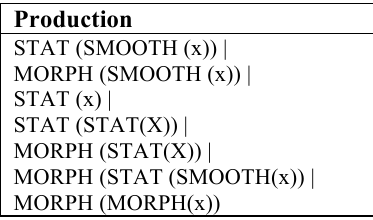
Table 3: Grammar used to generate features. Additionally, new features can be generated by adding, subtracting, multiplying or dividing any two features generated from these